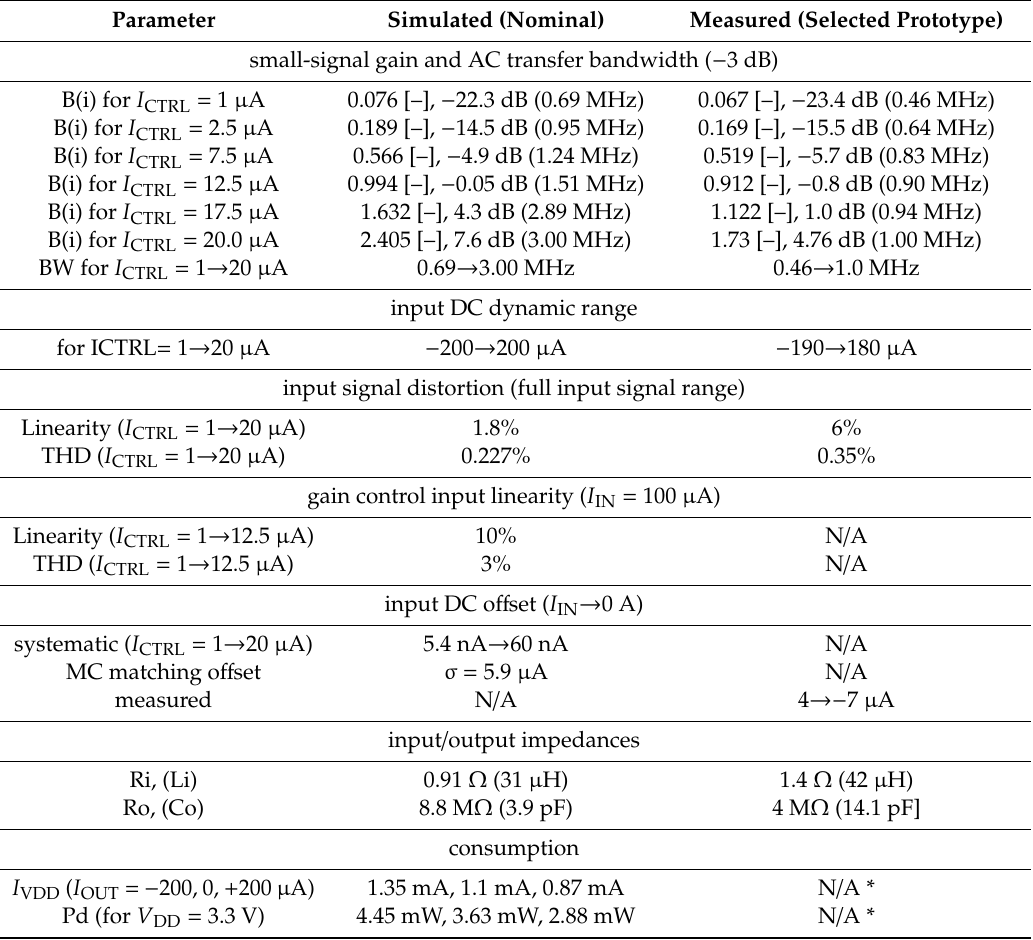
Figure 13. Frequency transfer characteristics with measured bandwidth in the scope (0.46 ÷ 1.0) MHz. Table 3. Amplifier properties summary.